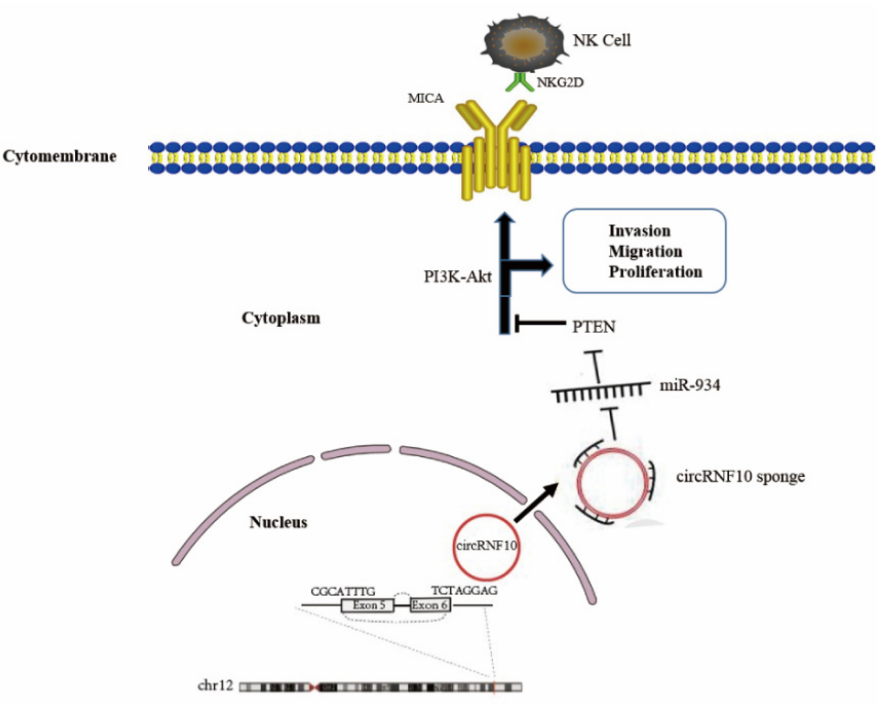
Figure 8. Possible mechanism by which circRNF10 suppress proliferation, invasion, and migration sponge to regulate PTEN expression and PI3k/Akt/MICA signaling in BC of BC cells and enhances killing efficiency of NK-92MI cells against BC cells by acting as an miR-934 sponge to regulate PTEN expression and PI3k/Akt/MICA signaling in BC cells.